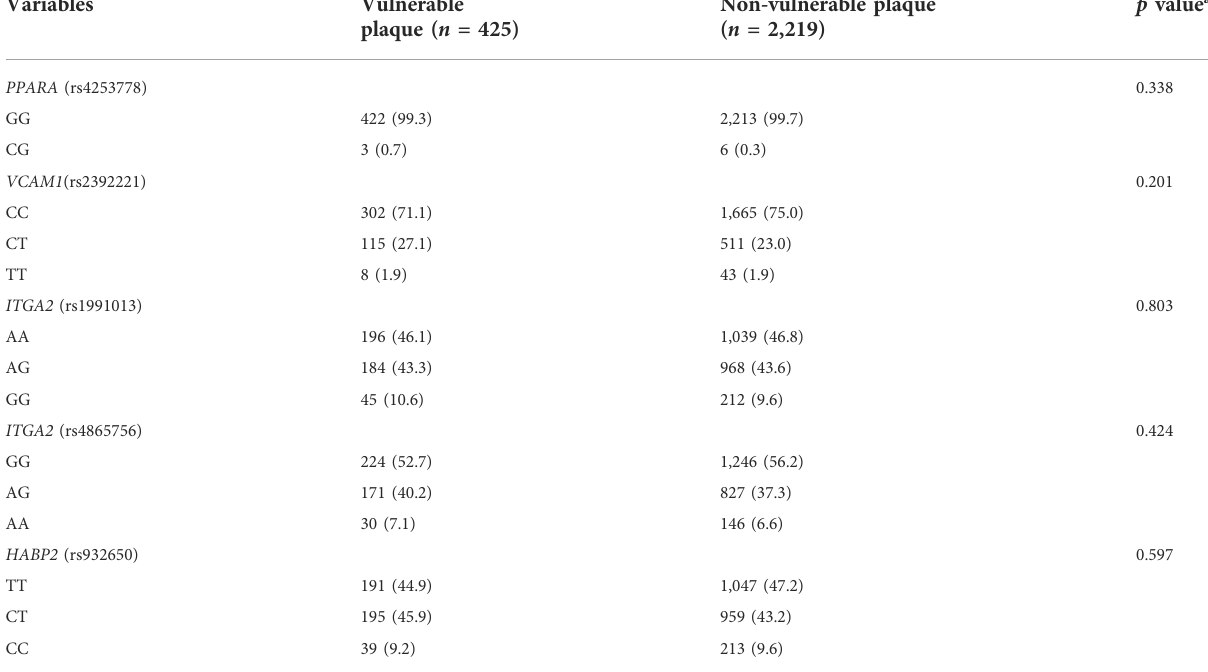
TABLE 2 ( Continued ) Genotype distribution between vulnerable plaque group and non-vulnerable plaque group.